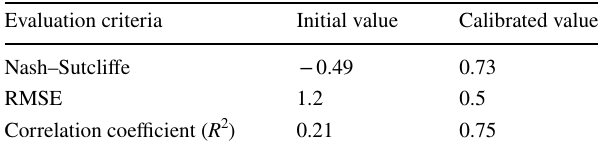
Table 14 Model output with their evaluation